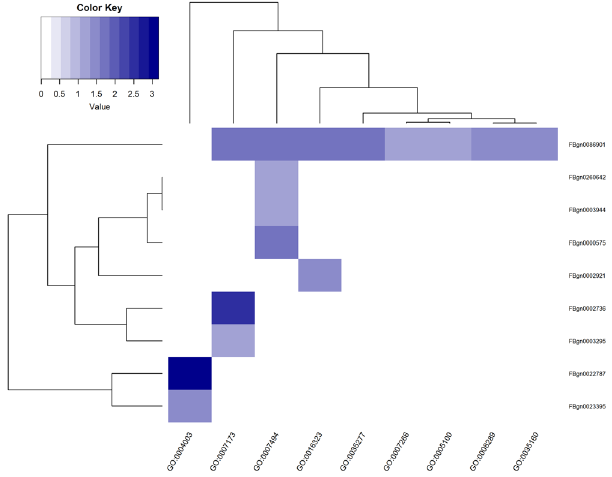
Figure 7. Heatmap showing the individual genes associated to CCRT for each of the top GO terms. The colour scale indicates the degree of association (expressed as − log(p)). The darkest blue colour indicates − log(p) = 4 and as the colour fades p-values